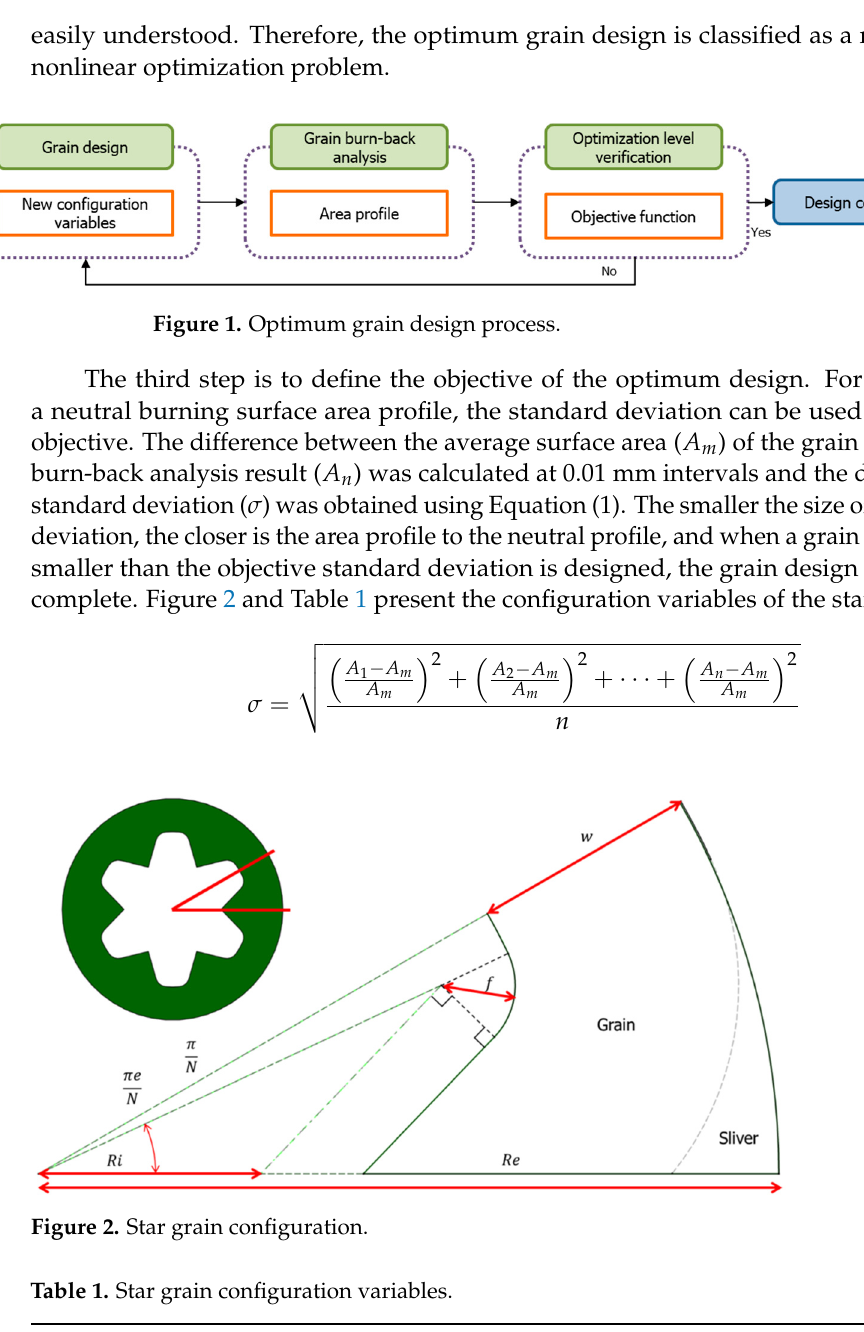
Figure 2. Star grain configuration. Table 1. Star grain configuration variables.